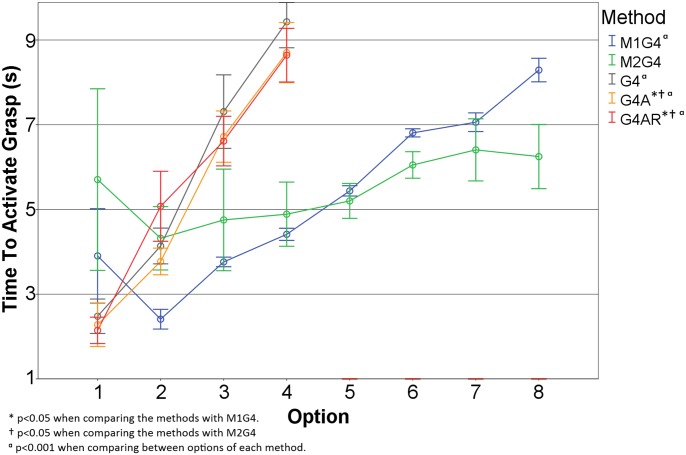
Time to Activate a Grasp Option for each of the methods used in this paper.The error bars indicate the standard error.